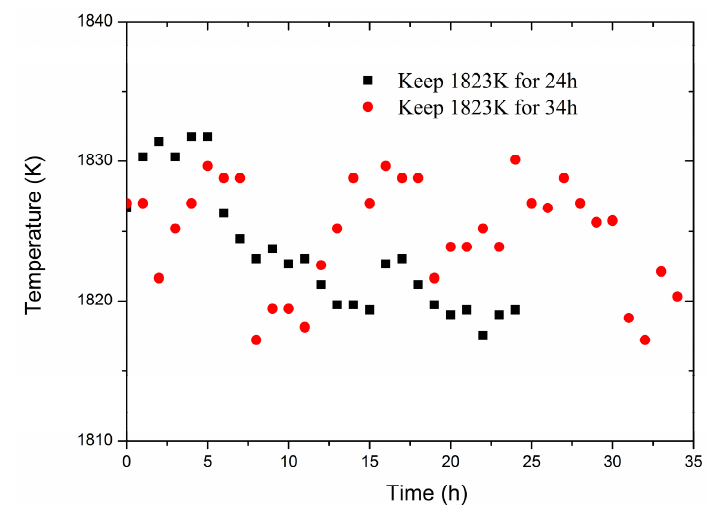
Figure 5. The temperature response of the optical fiber infrared radiation sensor keeping the temperature of 1823 K for 24 h and 34 h.